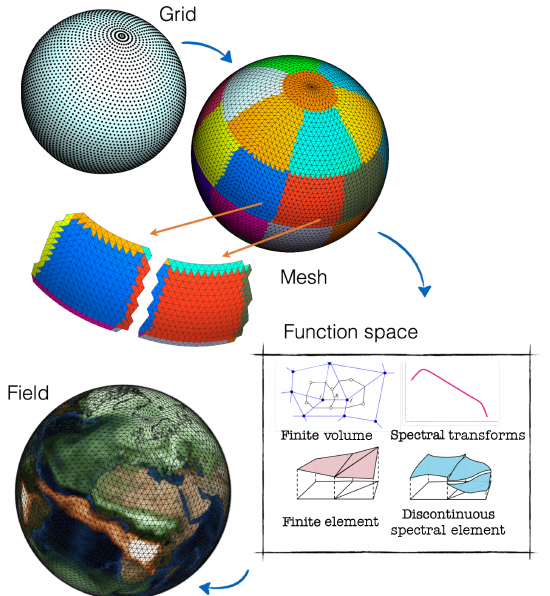
Figure 5. Conceptual workflow on how to use Atlas with most ap- plications.